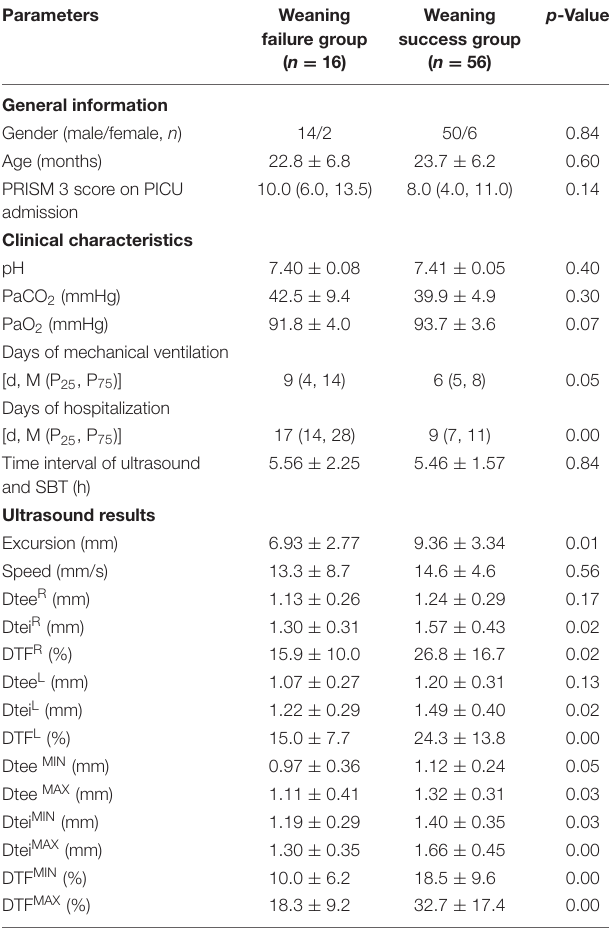
TABLE 2 | Comparison of the parameters before weaning between the failure group and success group.